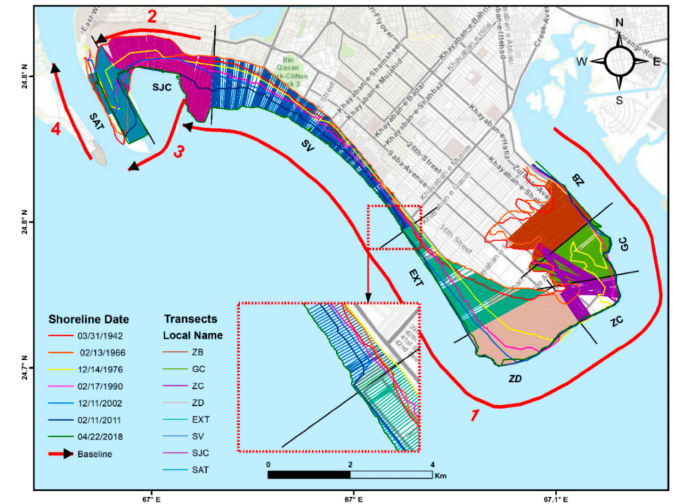
Figure 3. Digital shoreline analysis on the eastern zone (inset red doted rectangle shows a part of the study area) (ZB = Zone B; GC = Golf Club; ZC = Zone C; Ext = Extension, SV = Sea-view, SJC = Shireen Jinnah Colony, and SAT = South Asian Terminal) (Table 1).